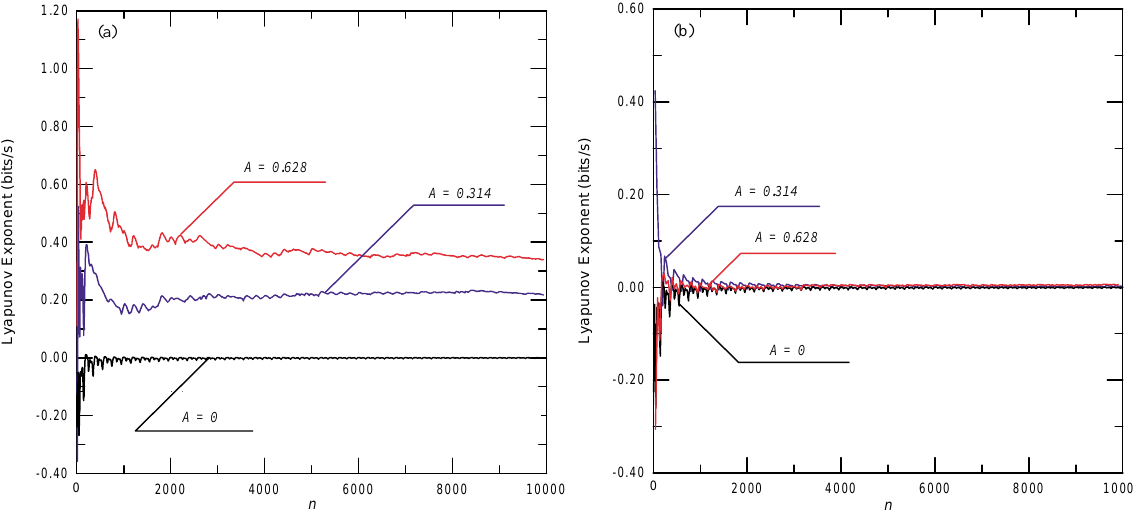
Fig. 7. Periodic signal: Algorithm due to Wolf et al. (1985). (a) t EV = 1 ; (b) t EV = 15 for A = 0 . 314 and t EV = 30 for A = 0 . 628 .